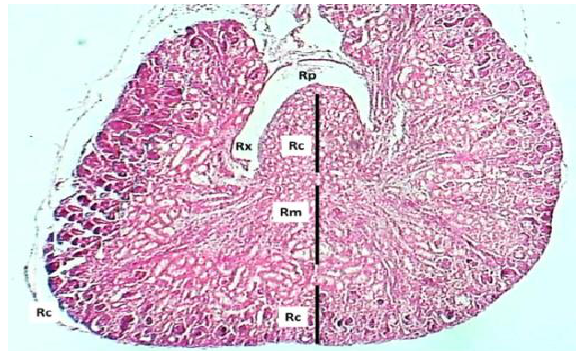
Figure, 2: photograph shows the right kidney (RK) and left kidney (LK) of male guinea pig. Note the hilus (white arrows) and left ureter (yellow arrow).